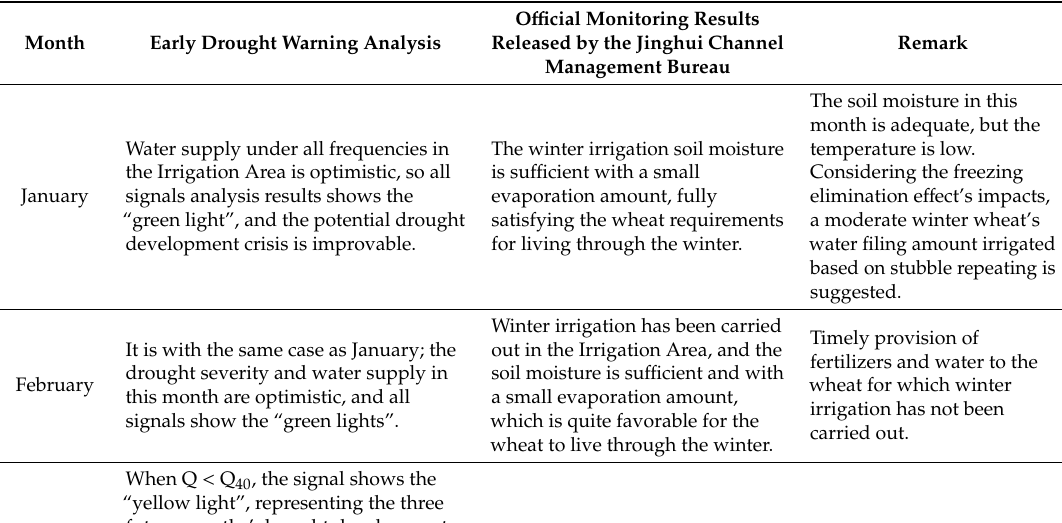
Table 14. Comparison between 2013 early drought warning and Jinghui Channel Irrigation Area’s monitoring